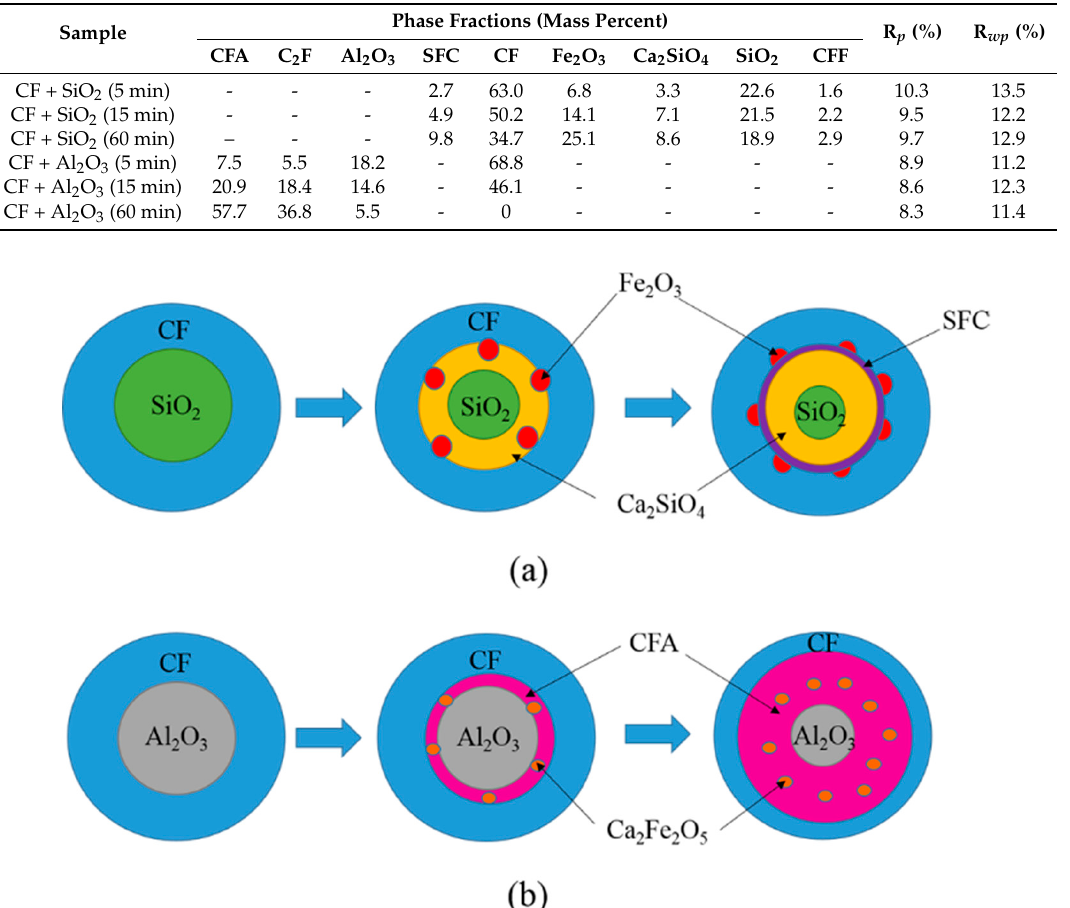
Figure 4. Schematic diagram of solid-state reactions ( a ) SiO 2 + CF; ( b ) Al 2 O 3 + CF.